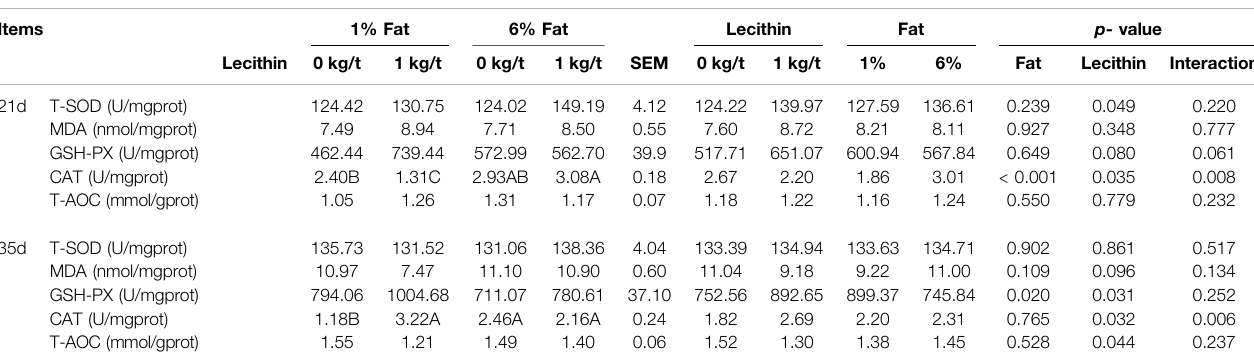
TABLE 4 | Effects of adding lecithin on serum Antioxidant Index of Laying Hens.